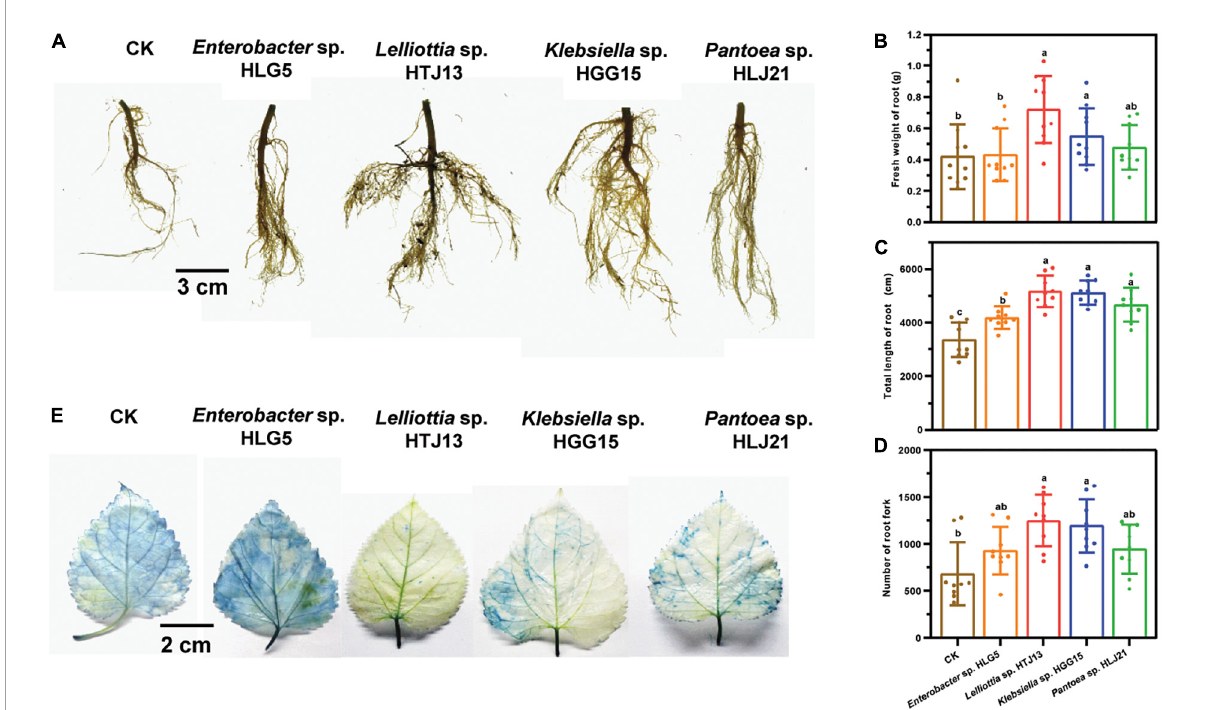
FIGURE2 Effect of potential four PGPBs on mulberry flood tolerance. (A) Root architecture of mulberry after suffering flood stress. (B) Fresh weight of mulberry root. (C) Total length of mulberry root. (D) Number of mulberry root fork. (E) Representative photograph of the damage of mulberry leaf suffering flood stress by Evan’s blue staining. Values represented the mean ± standard deviation of replicates ( n = 9). Different letters indicated statistical differences using Tukey’s one-way ANOVA ( P <